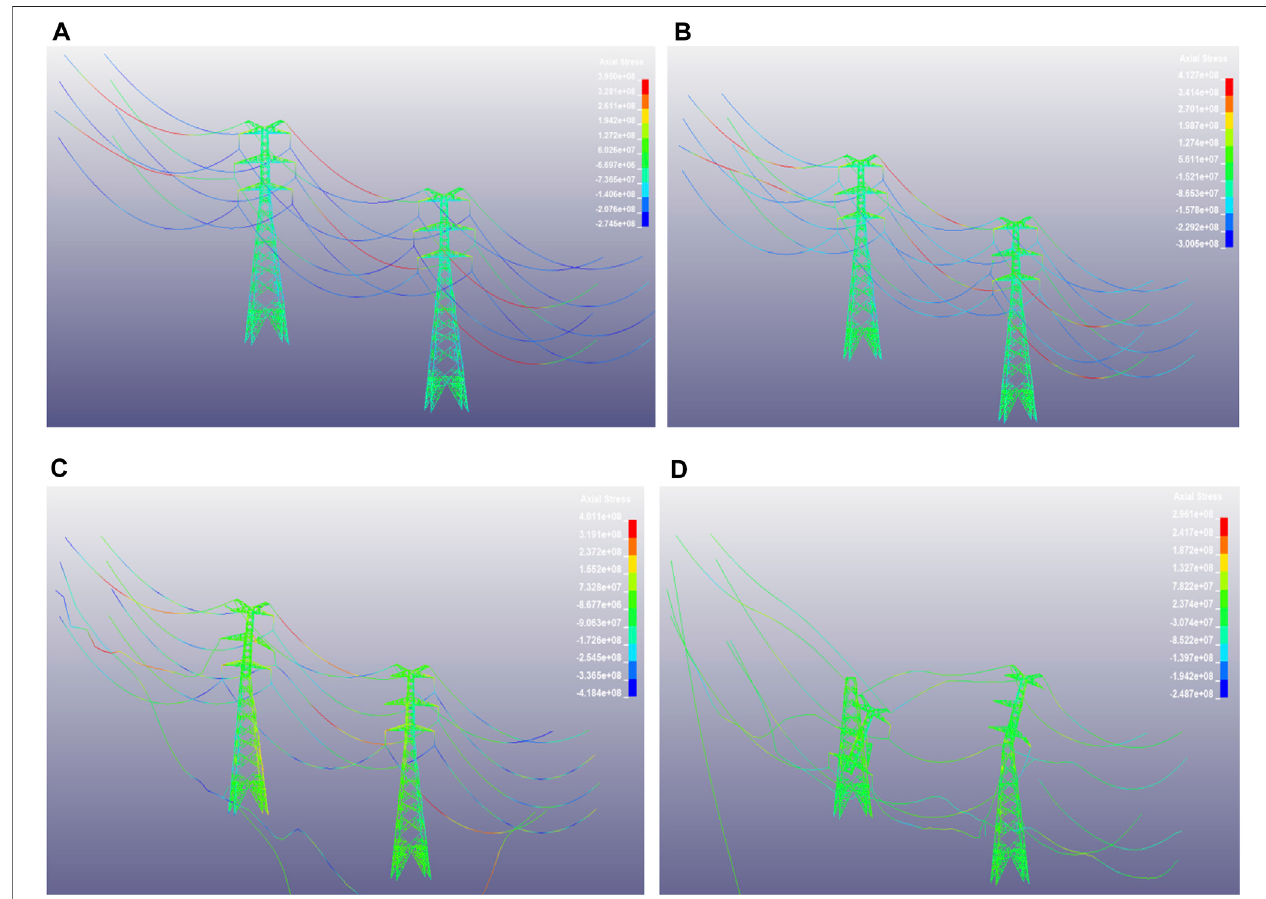
FIGURE 5 | Collapse process of the tower-line system due to ice shedding of the middle (A) 1.0 s (B) 1.5 s (C) 5.5 s (D) 7.0 s.